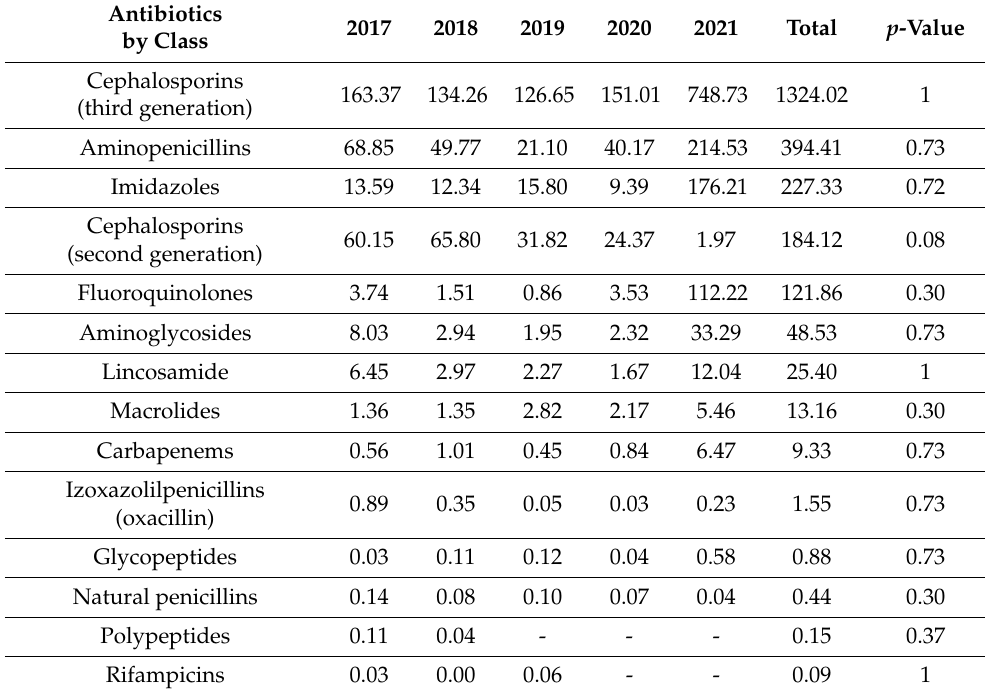
Table 3. Prescribed antibiotics by class expressed in DDD/100 bed days during the five years eval- uated.